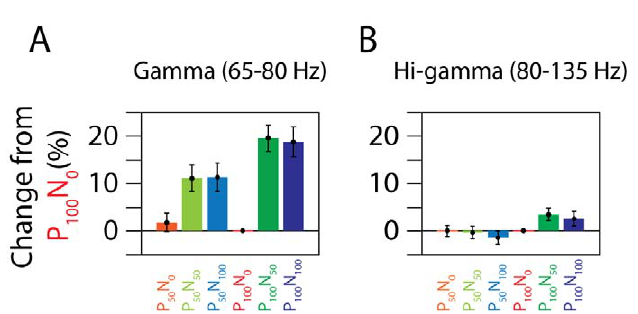
Figure 5. Percent changes in power from the P 100 N 0 condition for the gamma (A) and hi-gamma (B) ranges.